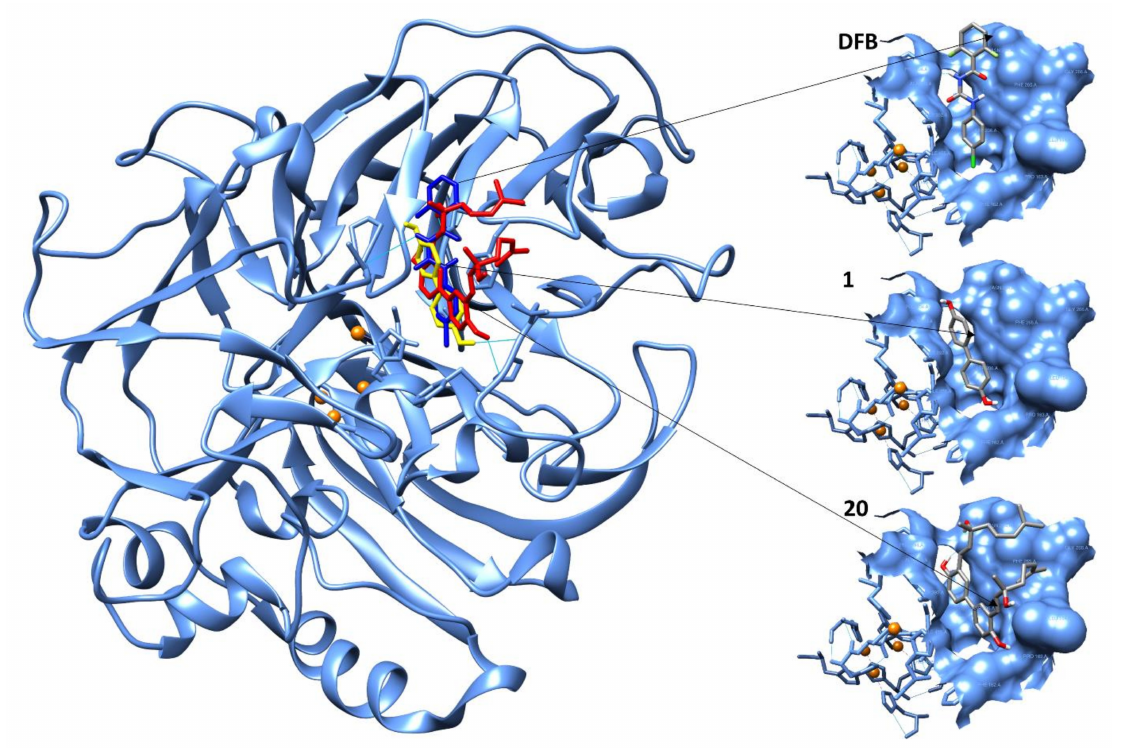
Figure 4. Representation of diflubenzuron ( N -[(4-chlorophenyl)carbamoyl]-2,6-difluorobenzamide) ( DFB ), compounds 1 and 20 with the catalytic T1 site of laccase performed with Chimera